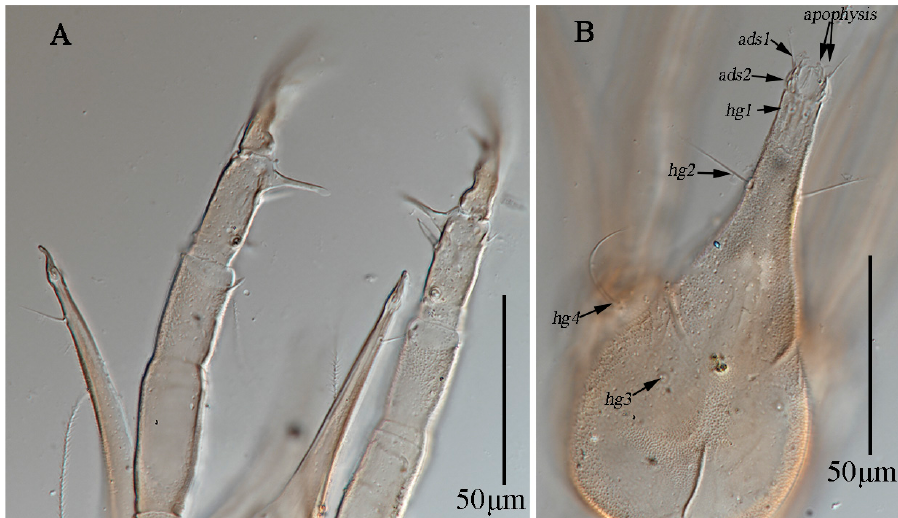
Figure 19. Brevicaudus trapezoides sp. nov. (male). ( A )—Palp and chelicerae (photo). ( B )—Subcapitulum (photo). Scale bar = 50 µm.